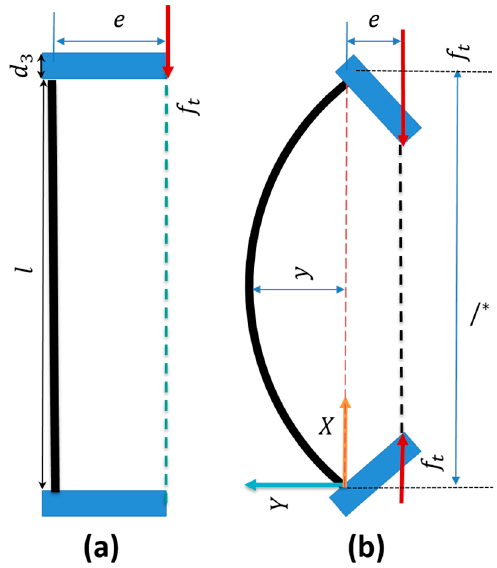
Figure 7 . Free body diagram. ( a ) The beam in the initial position and ( b ) bent . (cid:1864) = length of the beam; Figure 7. Free body diagram. ( a ) The beam in the initial position and ( b ) bent. l = length of the beam; e = eccentricity from the center; d 3 = thickness of the upper plate of the bending module; f t = bending force; y = deflection of the beam; l ∗ = variable length of the